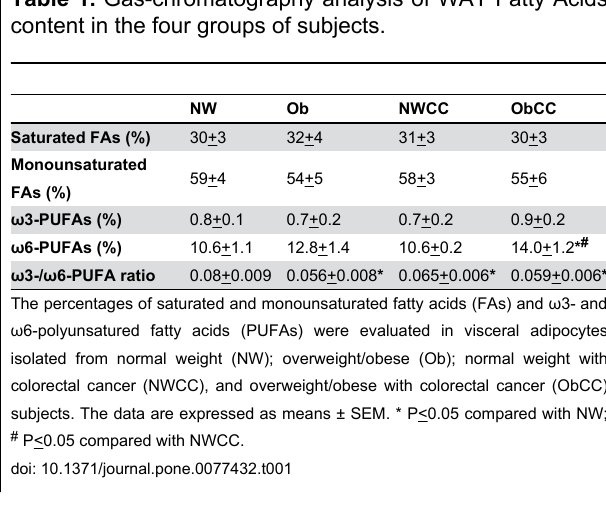
Table 1. Gas-chromatography analysis of WAT Fatty Acids content in the four groups of subjects.